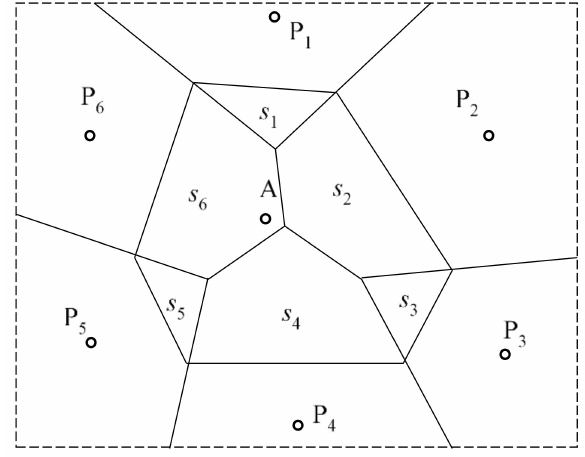
Figure 4. Schematic map of the natural neighbor interpolation method.